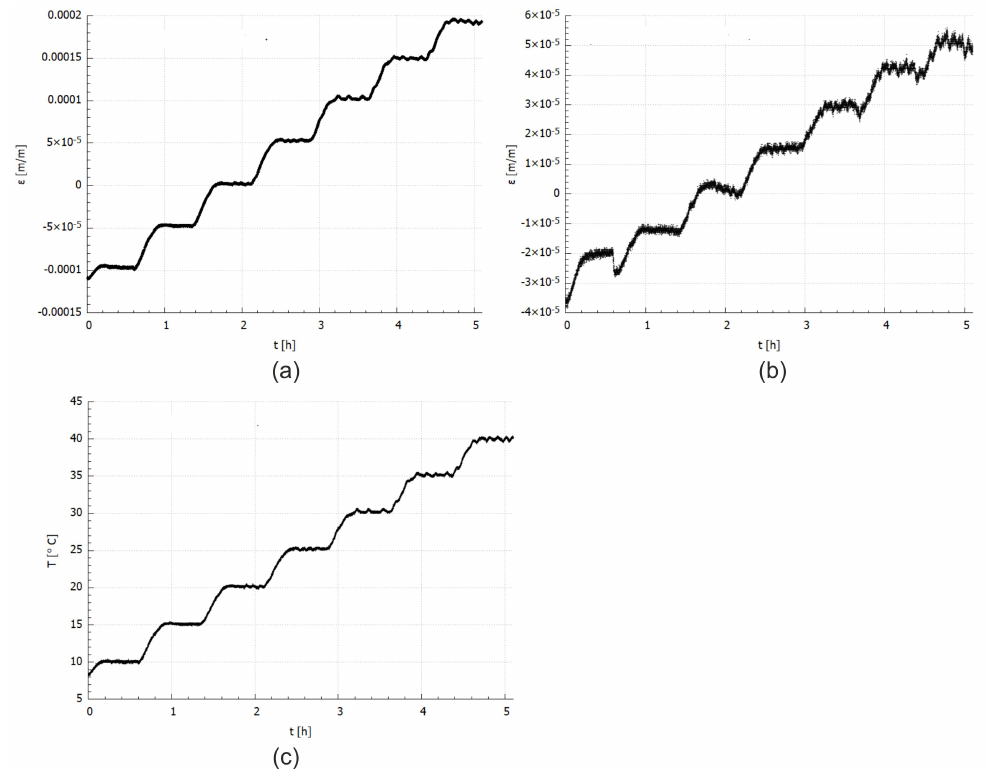
Figure 4. Experimental results: ( a ) CFRP total strain, ( b ) CFRP material strain, ( c ) temperature. Table 4. Polynomial constants ( × 10 − 3 ).